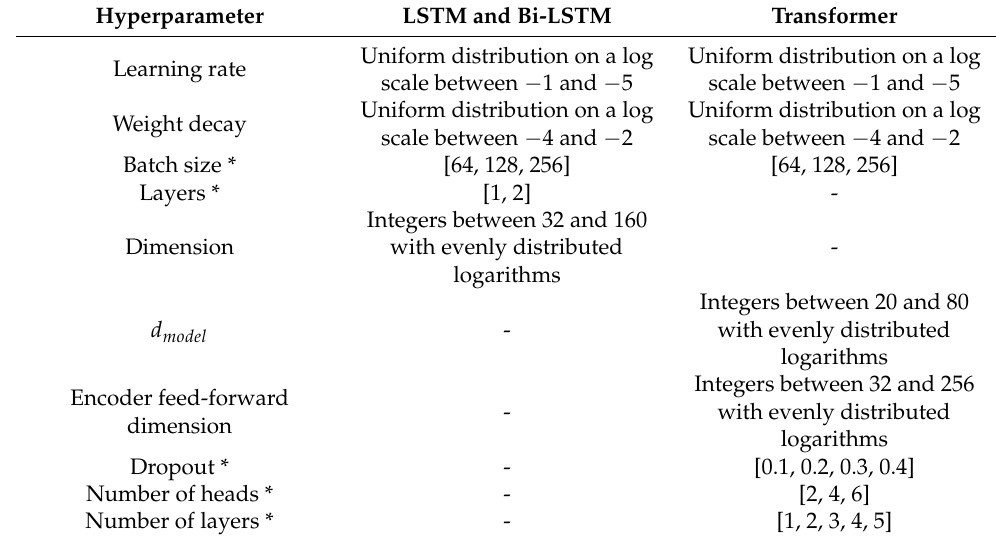
Table 2. Hyperparameters search space.